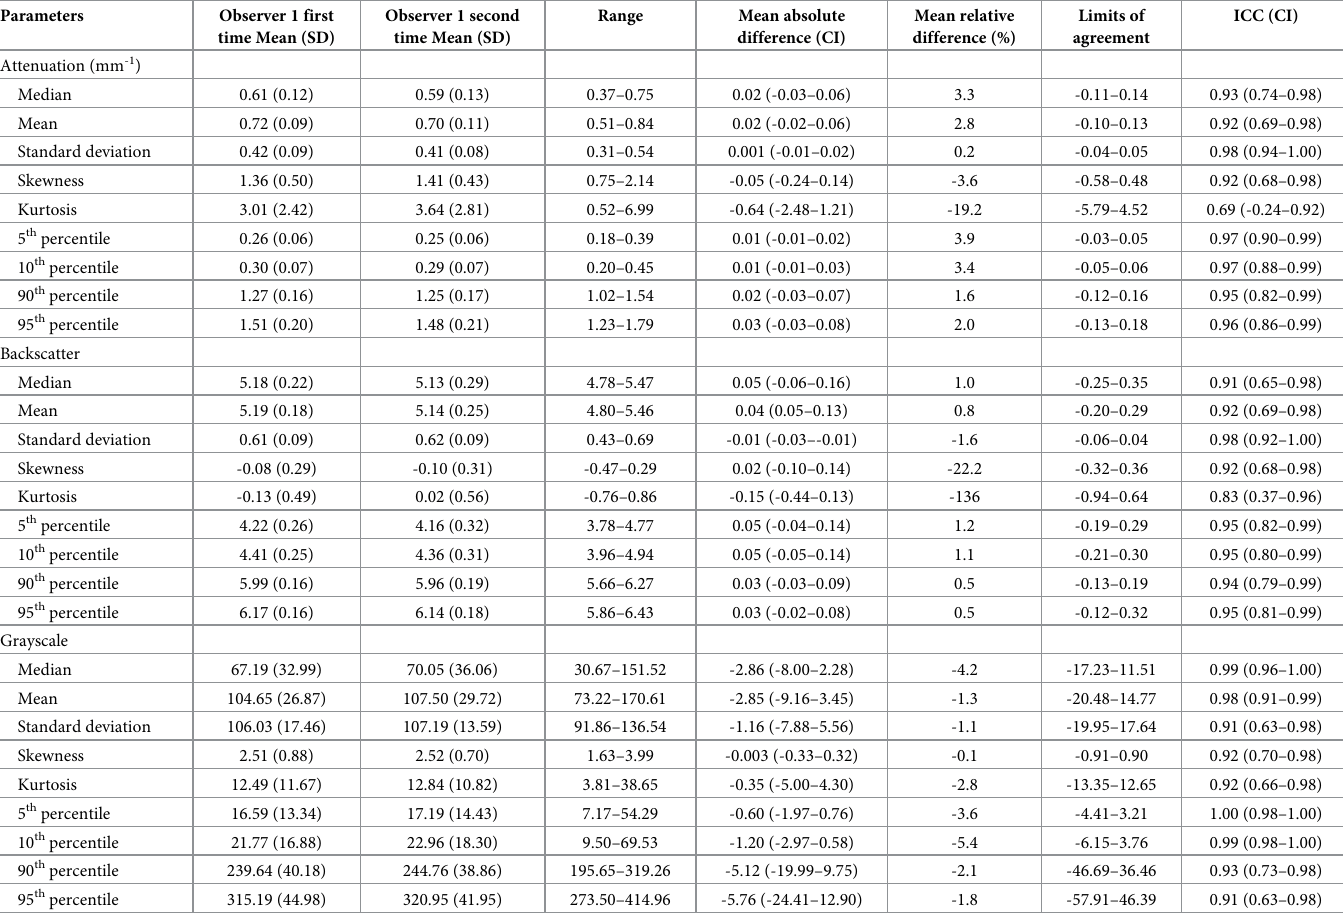
Table 3. Intraobserver variability of QCU-CMS